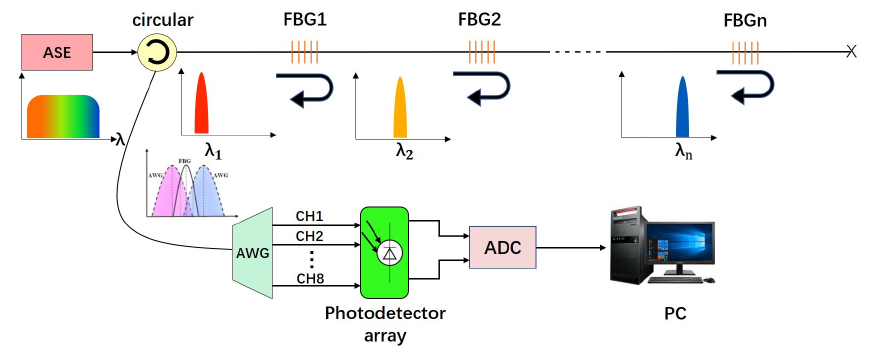
Figure 1. Schematic diagram of the AWG interrogation